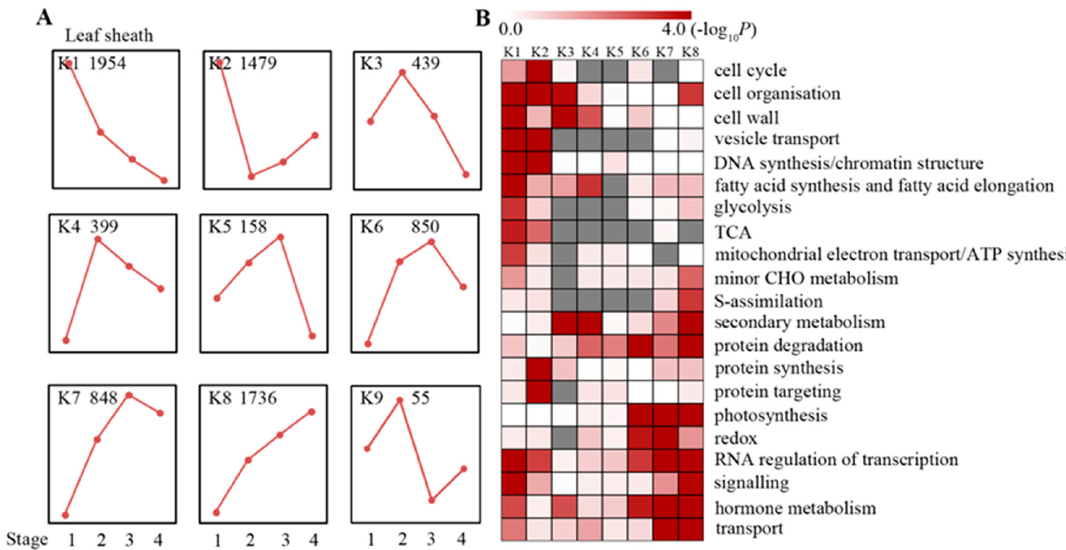
Figure 2. Transcriptome profiling during sheath maturation in maize. ( A ) K-means clustering showing the expression profile of the maize sheath transcriptome. Eight major clusters (K1–K8) were identified along the four developmental stages (stage 1 to 4) in sheath tissues from 7918 di ff erentially expressed genes. ( B ) Functional category enrichment was calculated using the MapMan binning method among the eight major clusters in A. The shade of red represents the significance level of log 10 transformed p -values calculated from Fisher’s exact test. Gray blocks indicate functional category enrichment was absent.